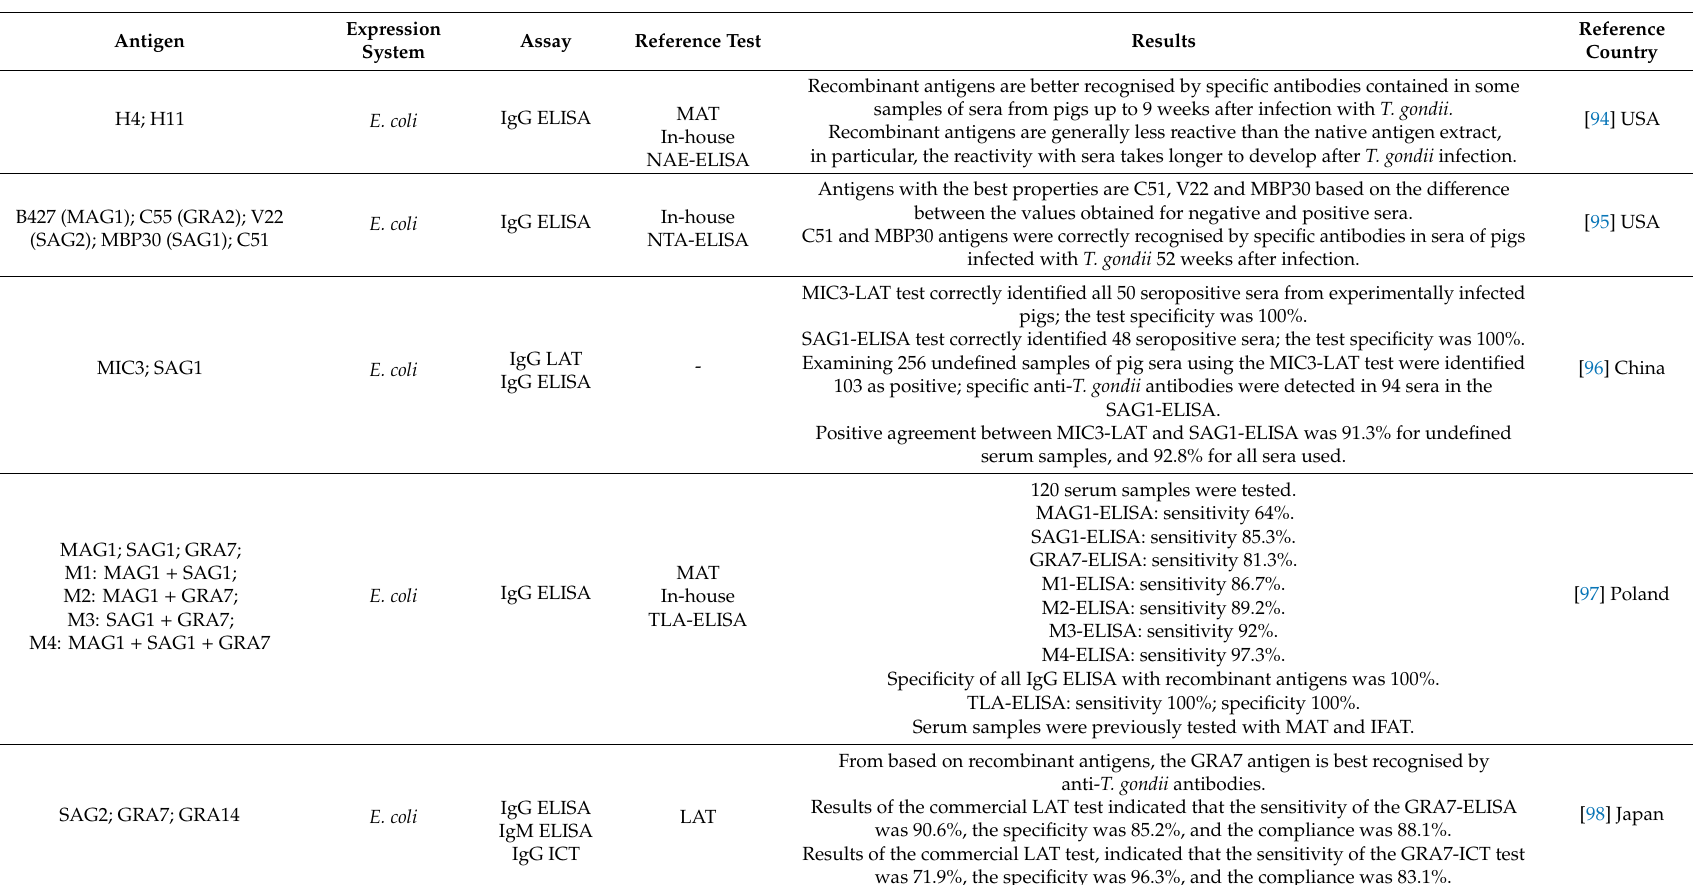
Table 7. Recombinant antigens used in detection of anti -T. gondii antibodies in porcine serum